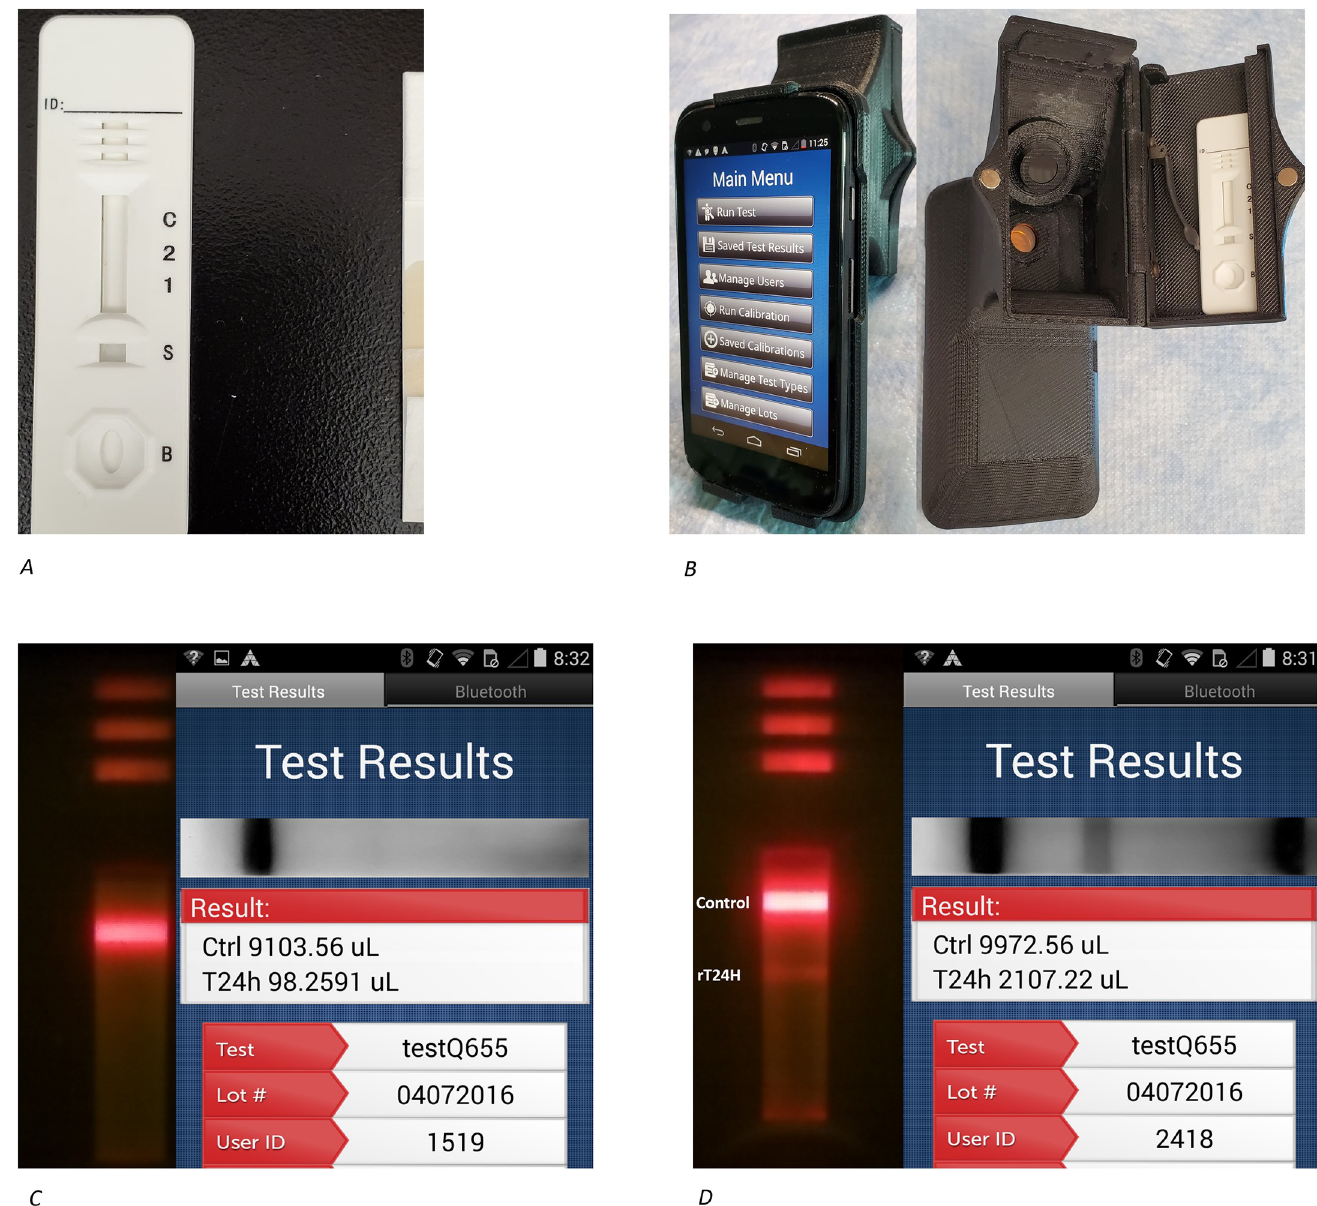
Fig 1. System view of the Qdot POC test device. A) Each 0.3 mm test strip was encased in one-time-use cassette and stored in a dry chamber to be read later with the mobile reader. B) The Holomics Reader HRDR-300 mobile device was used to measure fluorescent intensity of the Qdot complex after lateral migration of patient serum. C) Example of the result of a negative serum sample D) Example of the result of a positive serum sample.